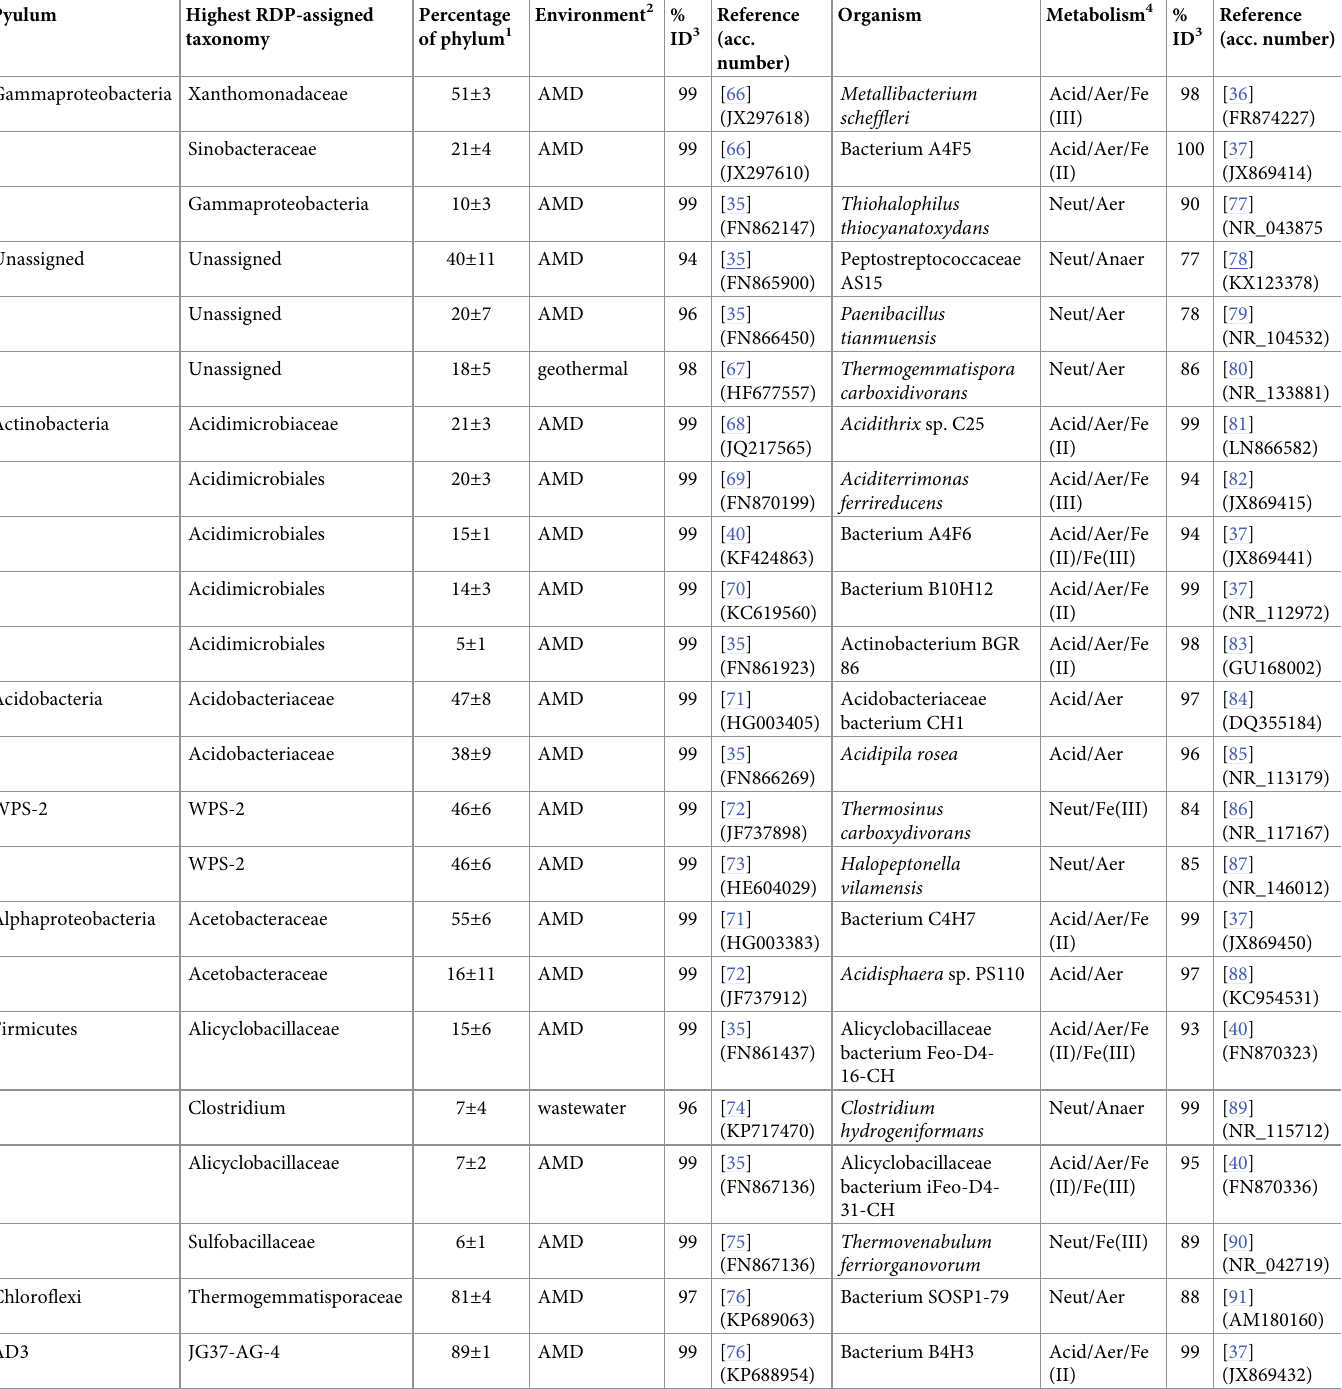
Table 1. Comparison (using BLASTn; [65]) of sequences recovered from iron mound sediment incubations to sequences contained in the GenBank database. Most closely-related 16S rRNA gene sequences from culture-independent surveys and microorganisms in culture are shown. OTUs comprising > 5% of a given phylum were selected for analysis and included in the